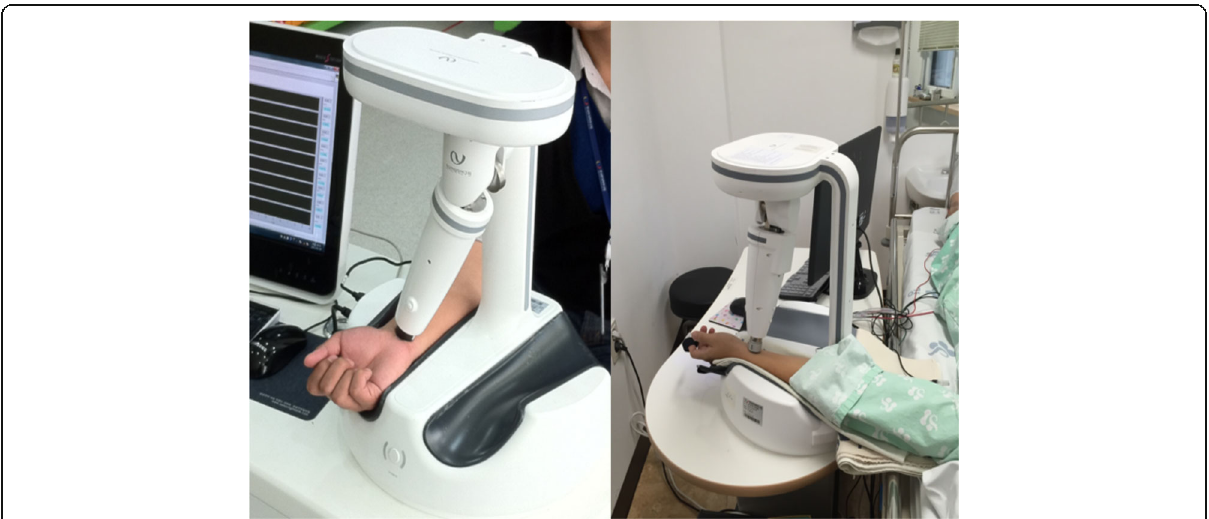
Fig. 2 The overall features of KIOM-PAS for the assessment of radial artery pulse pressure in different positions ( left : sitting position, right : lying position). The figure was epitomized from the previous article that described the study protocol of this study